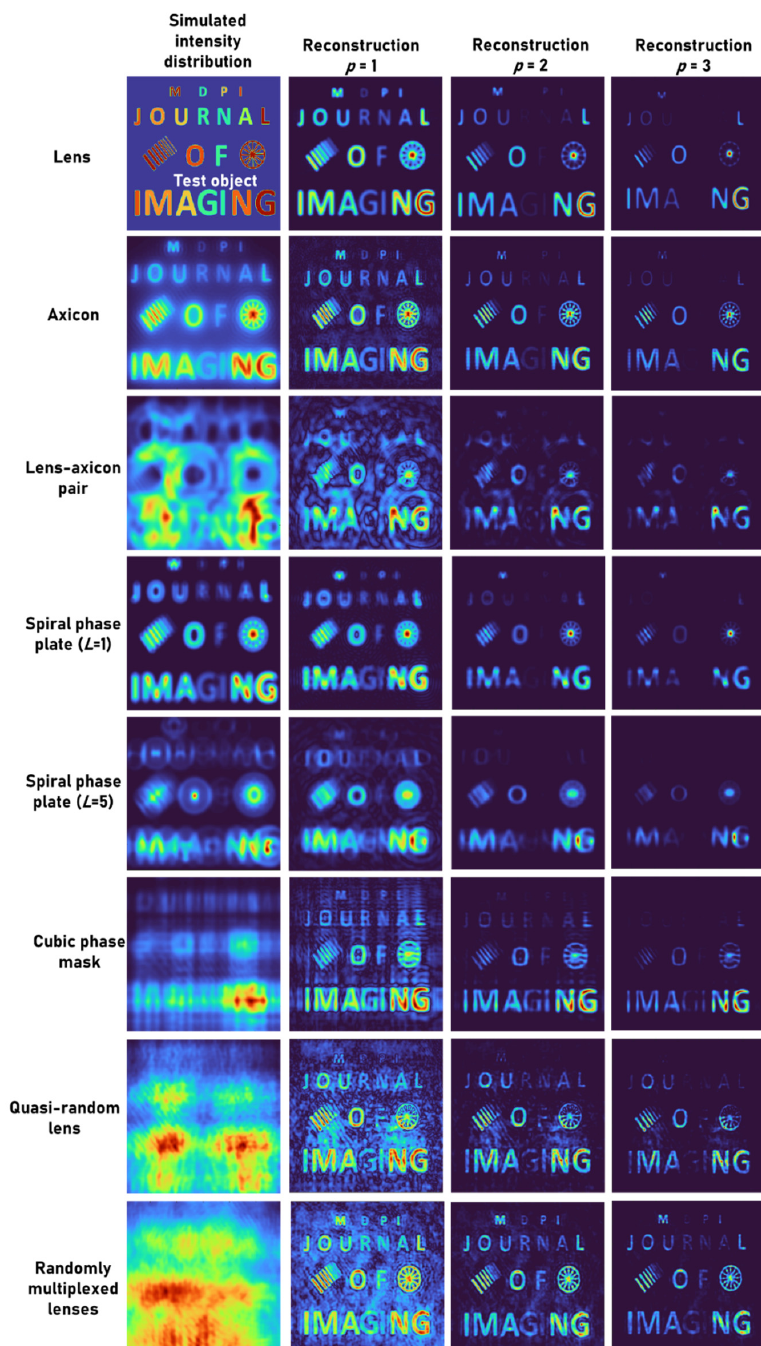
Figure 4. Simulated intensity distribution for a test object and the reconstruction results for p = 1, 2 and 3.